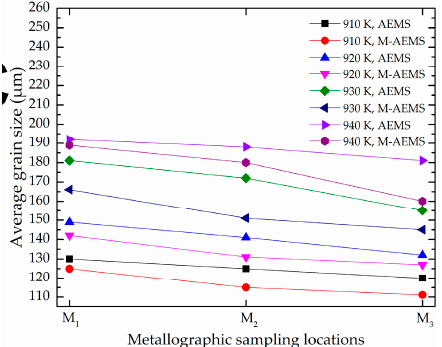
Figure 14. The average grain size of the disk pieces treated by AEMS and M-AEMS with the pouring temperatures of 910, 920, 930 and 940 K at different sampling locations.